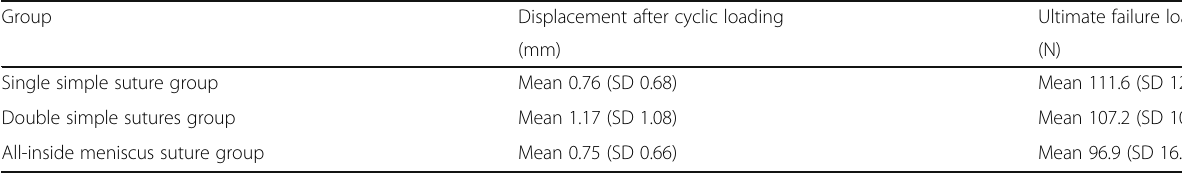
Table 1 Displacement after cyclic load and ultimate failure load Group Single simple suture